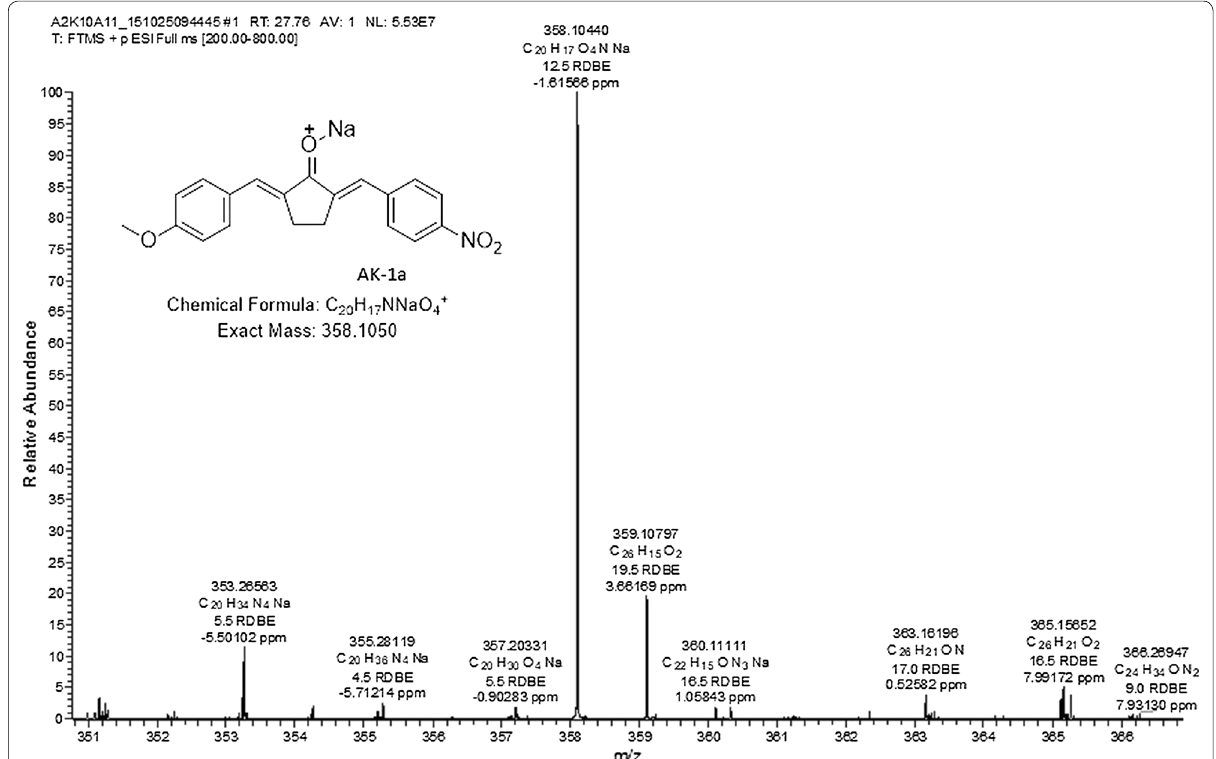
Fig. 2 Represents Fourier transform mass spectrometry (FTMS) of (2 E ,5 E )‑2‑(4‑methoxybenzylidene)‑5‑(4‑nitrobenzylidene) cyclopentanone